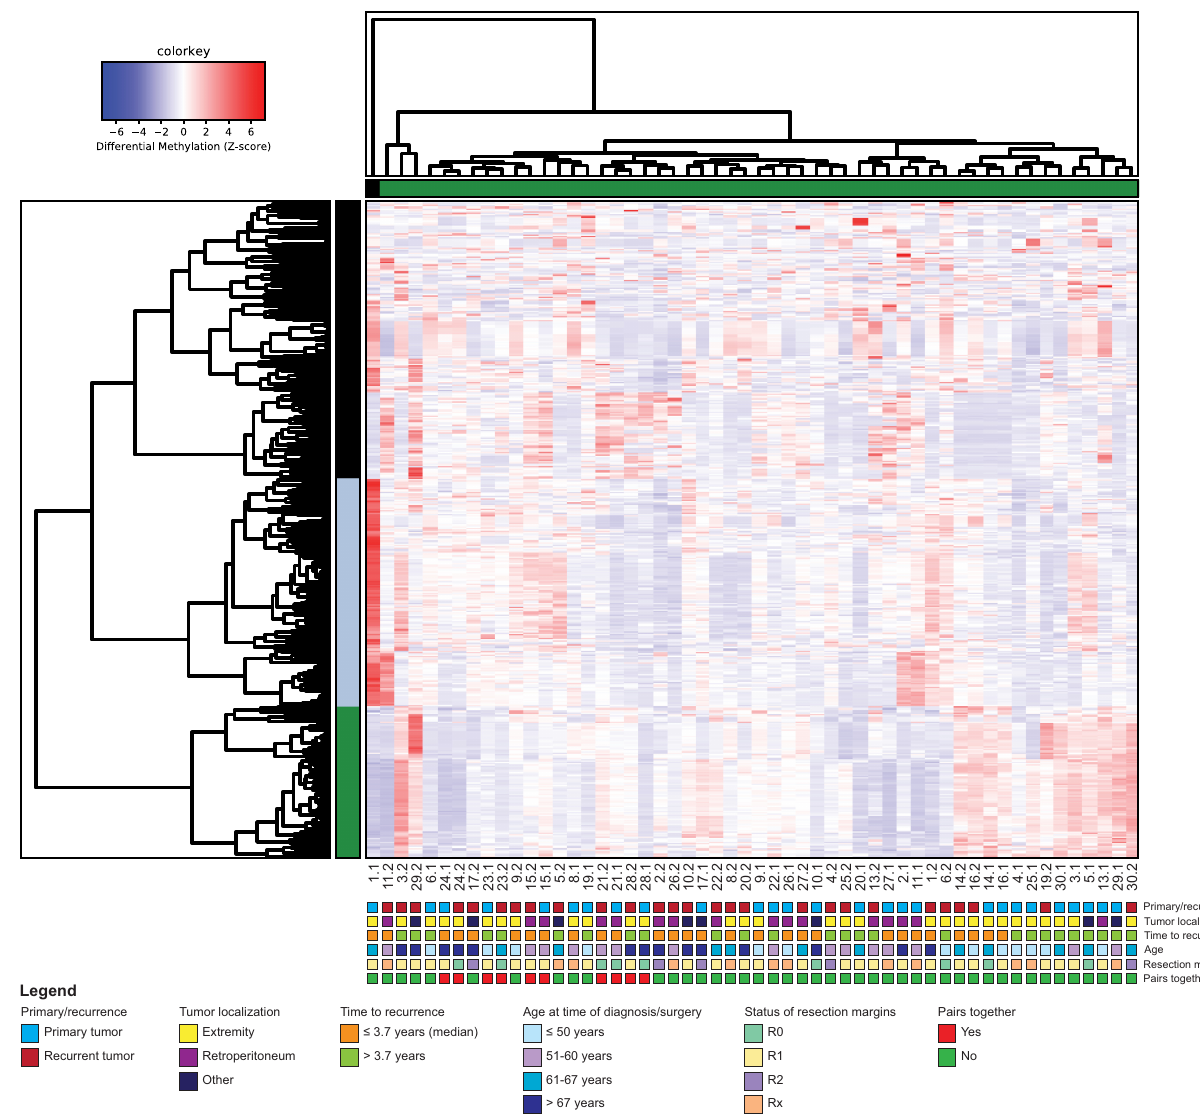
Fig 3. Hierarchical clustering based on differentially methylated DNA regions (DMRs) between primary and recurrent WDLPS samples. The heat map depicts a supervised clustering of the 27 paired WDLPS samples based on 455 differentially methylated regions (DMRs), excluding sex chromosomal regions (N = 15 DMRs), together with the clinicopathological features time to recurrence, tumor localization, age and the status of the resection margins.